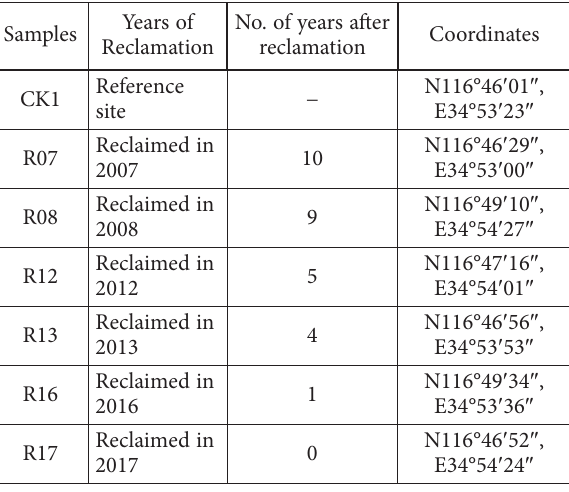
Table 1. Description of samples taken in Peixian, China Years of No. of years after Samples Reclamation reclamation